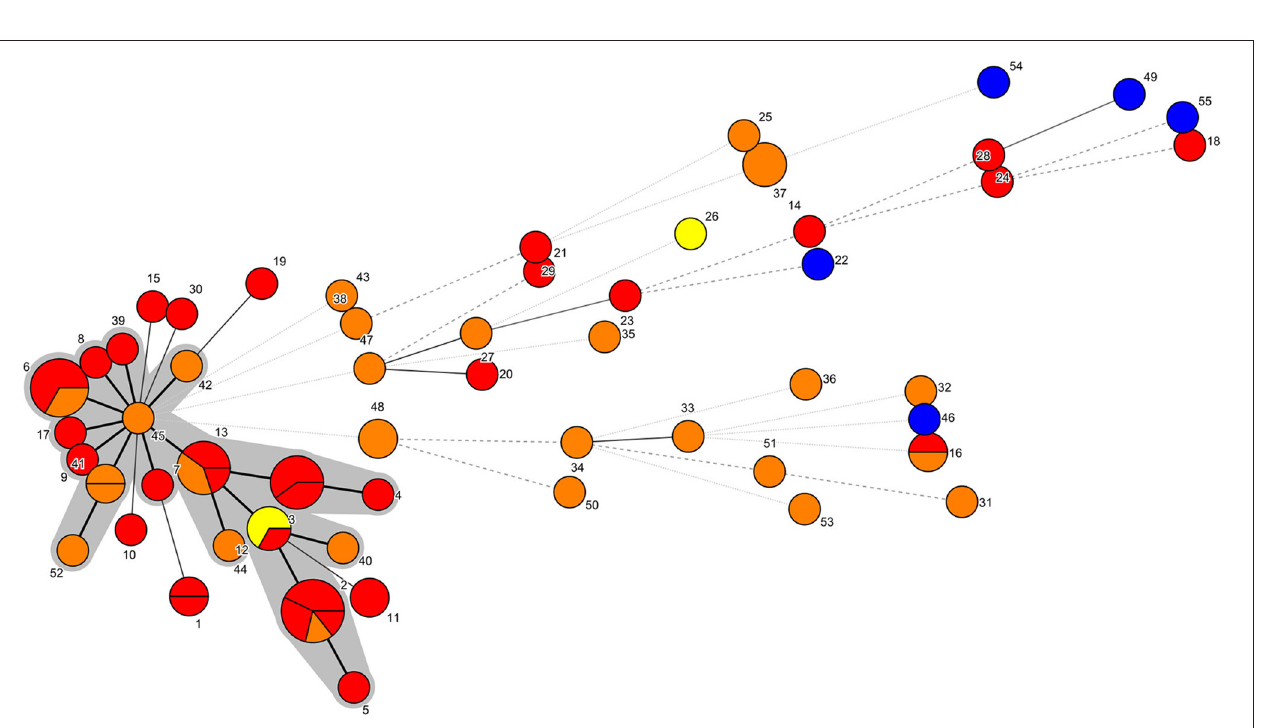
FIGURE 1 | MST representation. Each node represents a different ST, which is indicated by a number. The number of partitions represents the number of isolates belonging to that ST. Bold continuous lines link isolates with STs which differ in one allele only. Light continuous lines link isolates with STs differing in two alleles. Dotted lines (bold or light) link isolates whose STs presented three or more alleles of difference. The shaded area includes the isolates belonging to the CC45. Yellow: PDD isolated before January 2013. Red: PDD isolated between January 2013 and March 2013. Orange: PDD isolated after March 2013. Blue: ATCC PDD and PDP